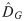
Visual summary of the source set analysis results for the STAT3 dataset.(Left) KEGG pathways containing STAT3 and all genes appearing in at least one estimated source set are cross-tabulated. The color of the cell (i, j) shows the relation between the i-th gene and the j-th pathway: blue if the gene belongs to D^G (primary source set), light blue if it belongs to D^G\D^G (secondary set), grey if the gene is participating in the considered pathway, and white otherwise (i-th gene does not belong to j-th pathway). (Right) This plot features KEGG pathways containing STAT3 and having a non-empty estimated source set, as well as all genes appearing in at least one estimated source. The three levels are to be read from left to right. A link between left element a and right element b must be interpreted as a ⊆ b. A module is defined as a subset of a source set belonging to a connected subgraph of the associated pathway.